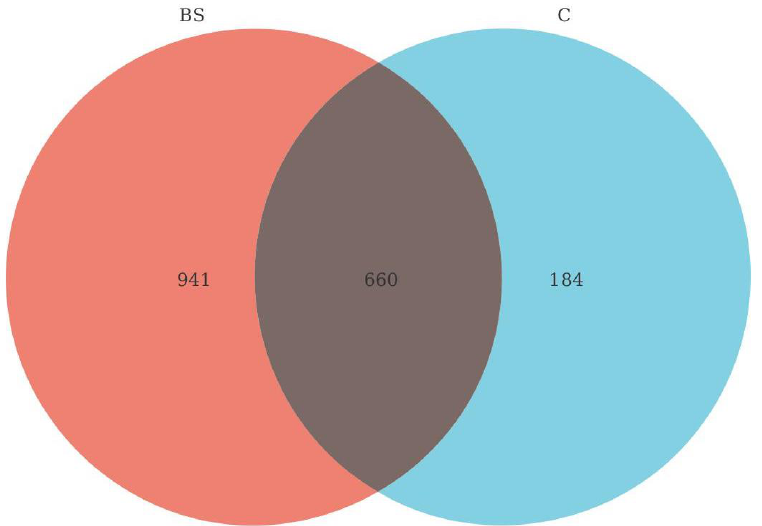
Figure 2. Venn diagram of OTU distribution in GIT. Each petal in the diagram represents a sample, and different colors represent different samples. The core number in the middle represents the total number of mutual OTUs in all samples, and the number on the Venn represents the number of unique OTUs in the sample.